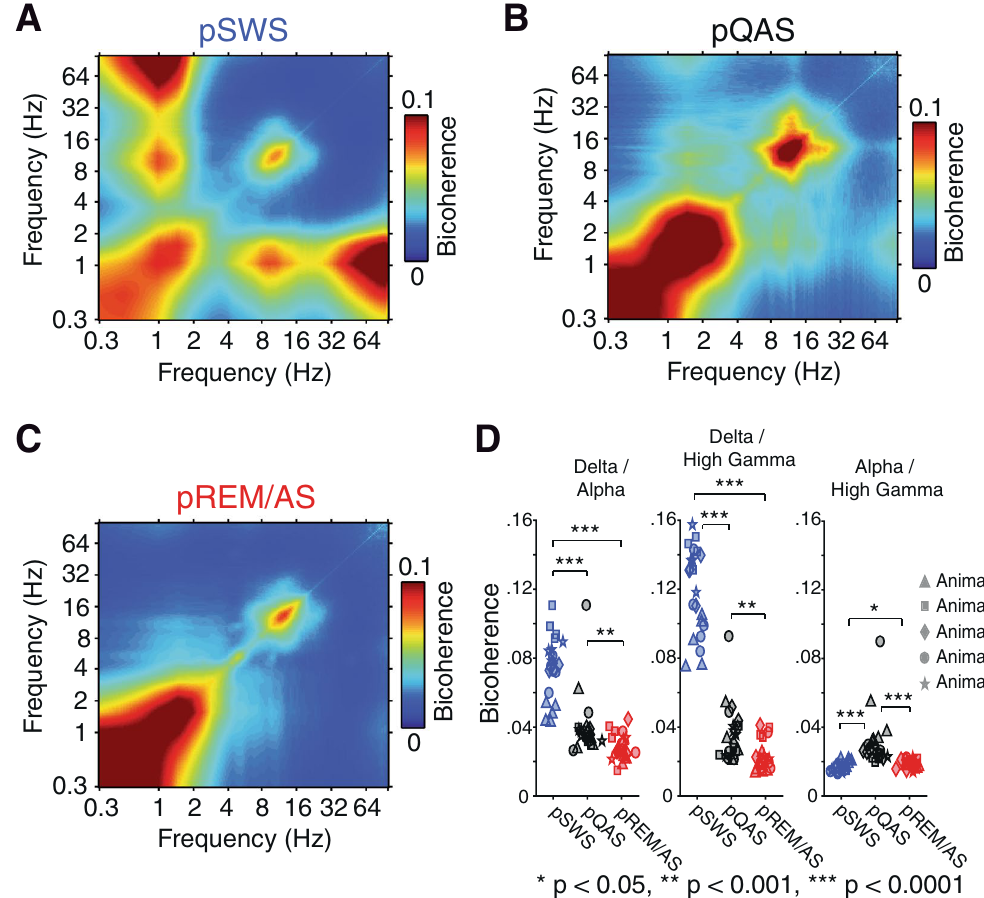
Figure 5. State dependent changes in phase amplitude coupling measured using bicoherence. ( A ) Population average bicoherence spectrum during the pSWS state. Note the prominent coupling between delta (~1 Hz) and alpha (8–16 Hz), as well as delta and high gamma (60–200 Hz) frequencies. In addition, delta and alpha oscillations are coupled to their first harmonic. ( B ) Population average bicoherence spectrum during the pQAS state. Note the weak coupling between alpha (8–16 Hz) and high gamma (60–200 Hz) frequencies. ( C ) Population average bicoherence spectrum during the pREM/AS state. In contrast to other states, pREM/AS displays fewer cross frequency interactions. ( D ) The strength of bicoherence for identified frequency-frequency interactions for each recording session ( * p < 0.05, ** p < 0.001, *** p < 0.0001, Kruskal-Wallis test, Bonferroni corrected